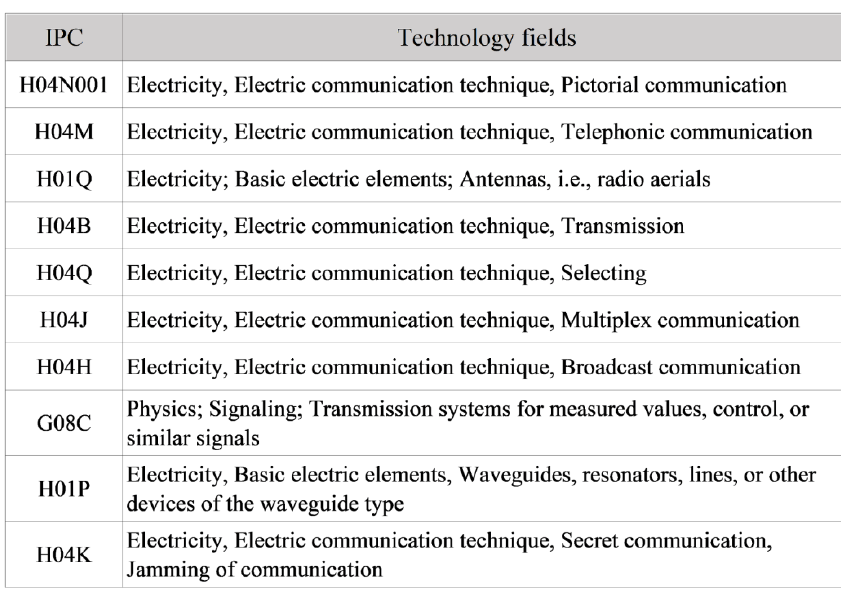
Fig. 10 IPC distribution in telecommunications.